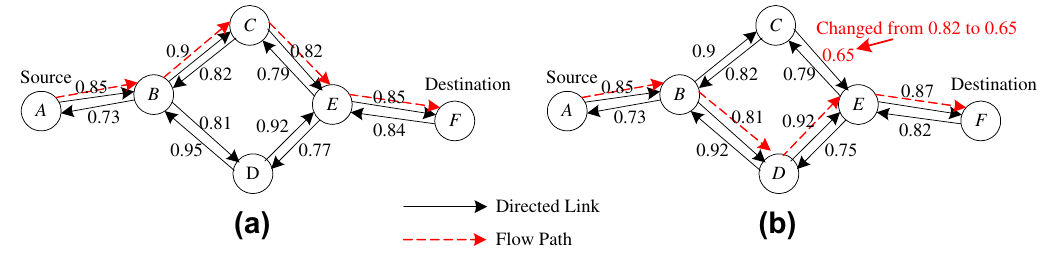
Figure 5. The Hand-off process: ( a ) the original route, from A to F; ( b ) the new route after the Hand-off